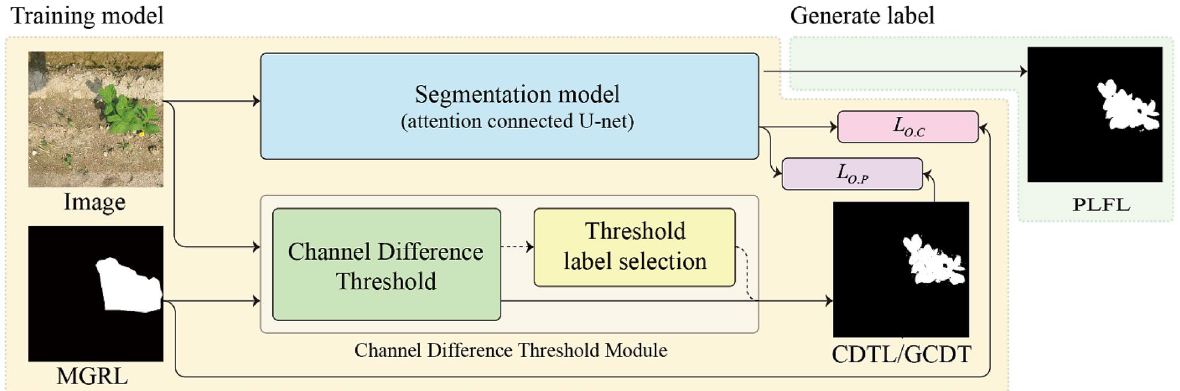
Figure 2. Overall framework of the proposed algorithm. The final PLFL requires a pair of pseudo labels, one generated manually and the other automatically. After that, the segmentation model can be trained with these coarse label pairs (CLPs) to generate PLFL.